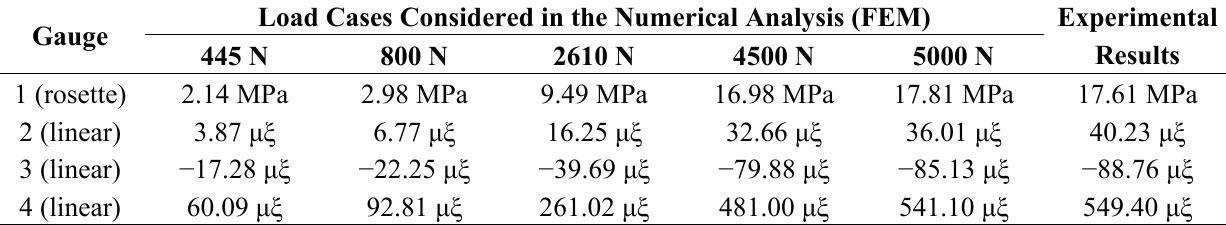
Table 3. Stresses and strains registered by the gauges for numerical and experimental results corresponding to an application depth of 0.17 m, considering the entire range of forward speeds and soil types.